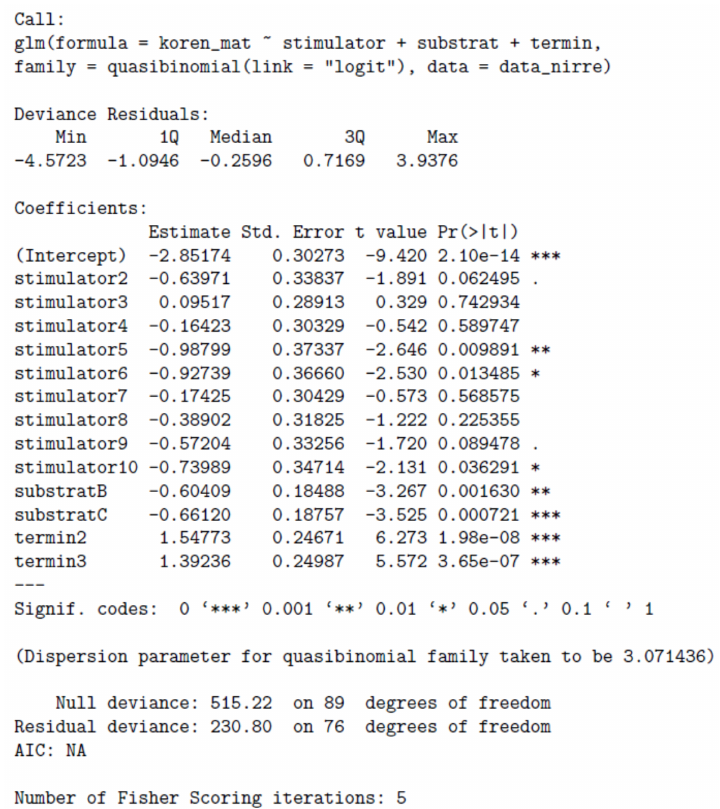
Figure A1. Parametrization of the quasi-binomial model predicting the proportion of rooted cuttings from all cuttings, including Wald tests of the significance of differences between the reference (Stimulator 1, Substrate A, Date 1) and remaining levels of each factor.